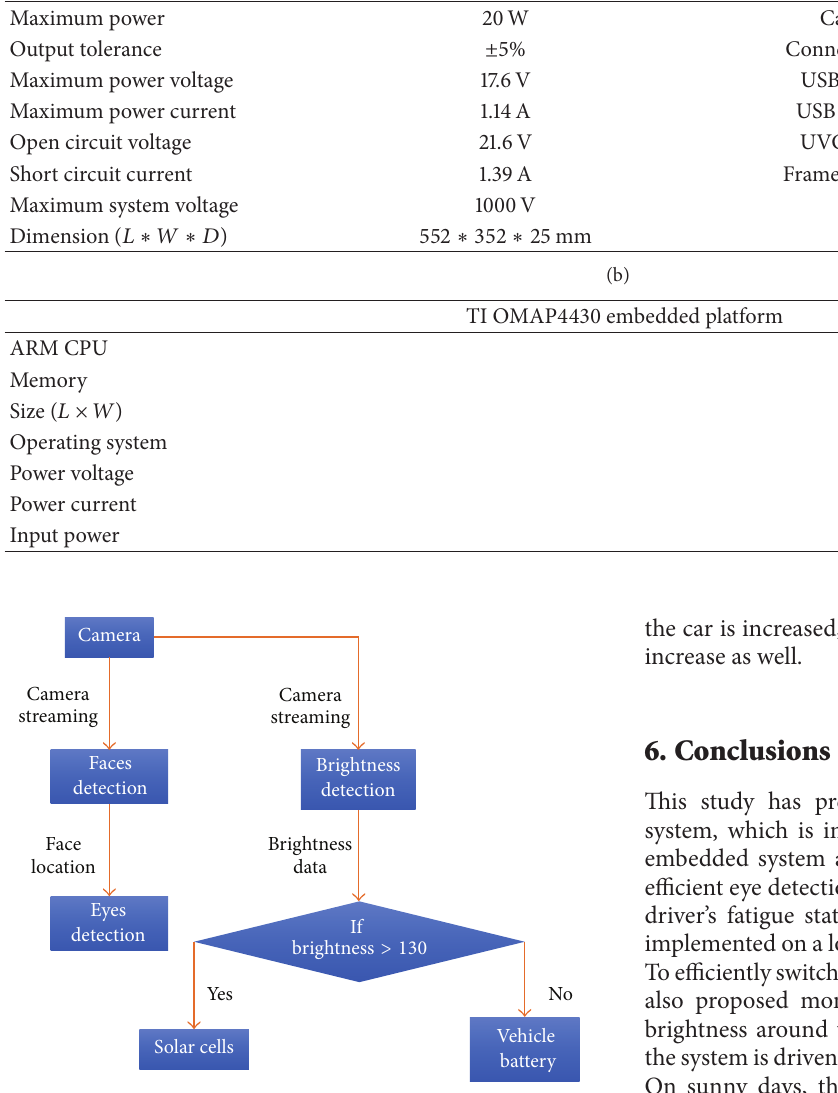
Figure 14: Software